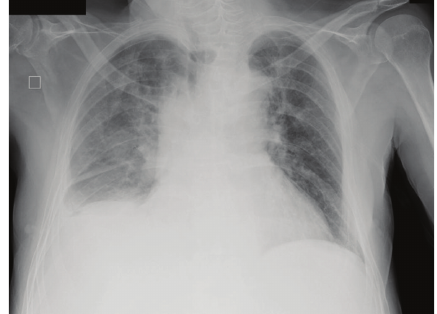
Figure 1: Chest X-ray on admission. Bilateral alveolar infiltrates with associated right pleural